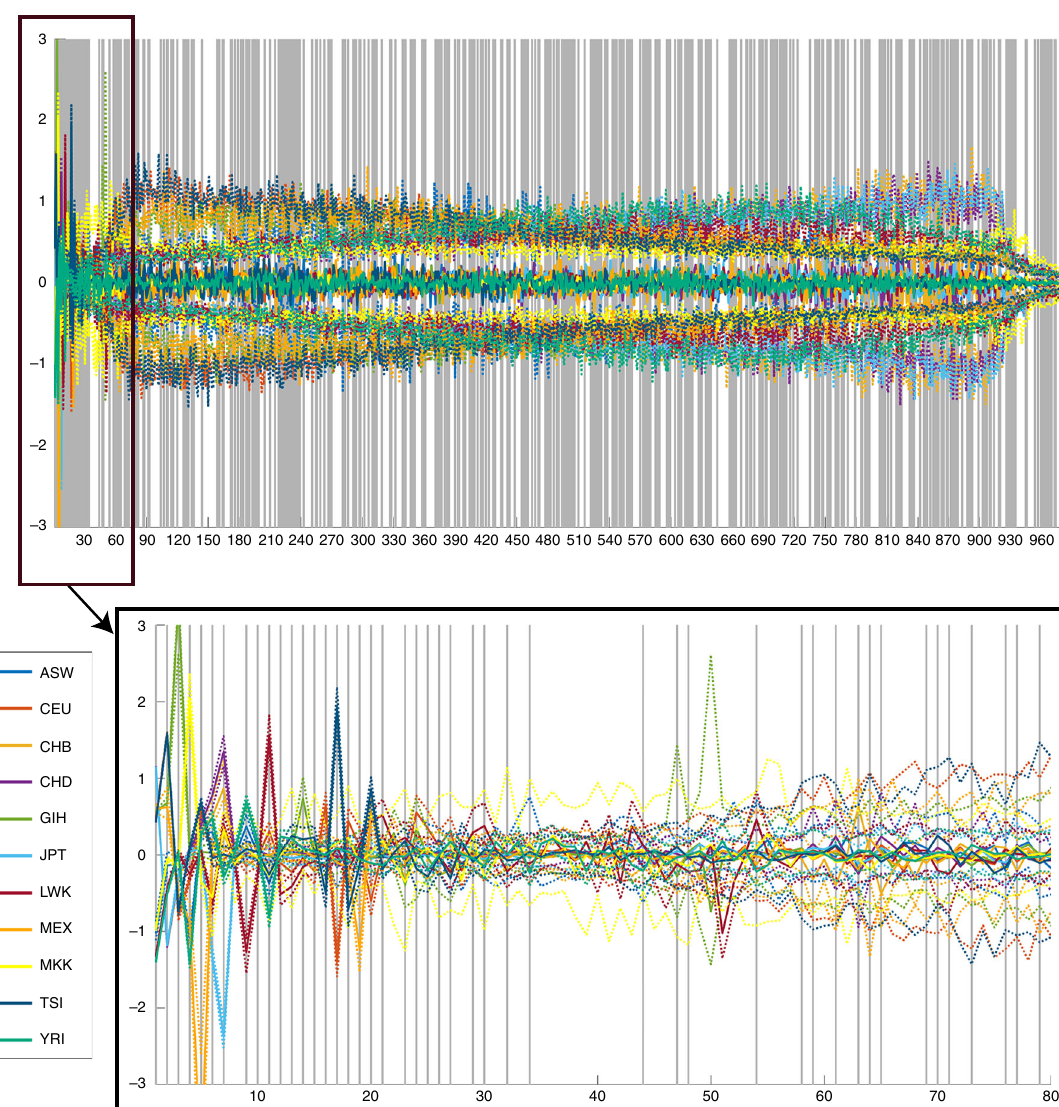
Fig. 2 Global genomic diversity shown by a parallel coordinate plot. Each genomic principal component (PC) from the Hapmap dataset is a single parallel line, plotted against the median (solid lines) and upper/lower quartiles (dotted lines) coordinate values (vertical axis) for each of the 11 HapMap populations 10 using different colors. Genomic PCs that tested signi fi cantly against facial variations are indicated with grey lines. The top genomic PCs, display strong between population differences, with population medians clearly either positive or negative. In contrast, in higher genomic PCs all population medians are close to zero, with population subgroups on either side (dotted lines). Interestingly, different populations structurally drive the between and within population differences along different genomic PCs. YRI: Yorubans from Ibadan; MKK: Masai from Kenya; LWK: Luhya from Kenya; CEU: Utah residents of Northern and Western European ancestry; TSI: Italians from Tuscany; CHB: Han Chinese from Beijing; JPT: Japanese from Tokyo; CHD: